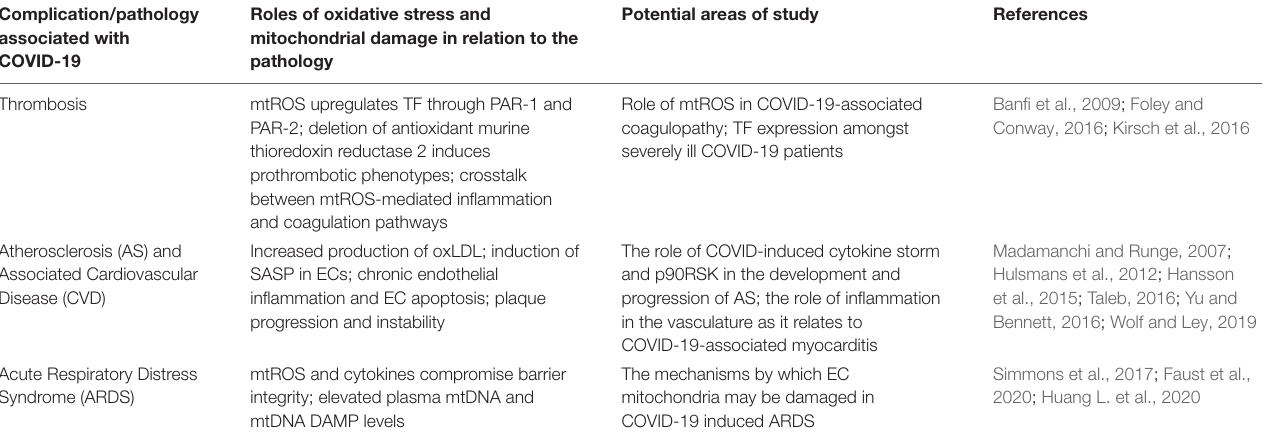
TABLE 3 | Comprehensive overview of COVID-19-associated complications and